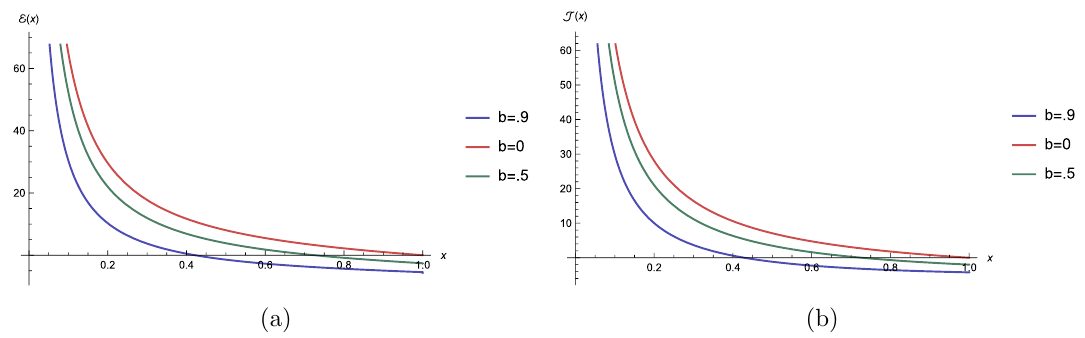
Figure 5. The energy E ( x ) and angular momentum J ( x ) of the rotating string for di(cid:11)erent values of (cid:13)ux parameter b with (cid:12)xed u 0